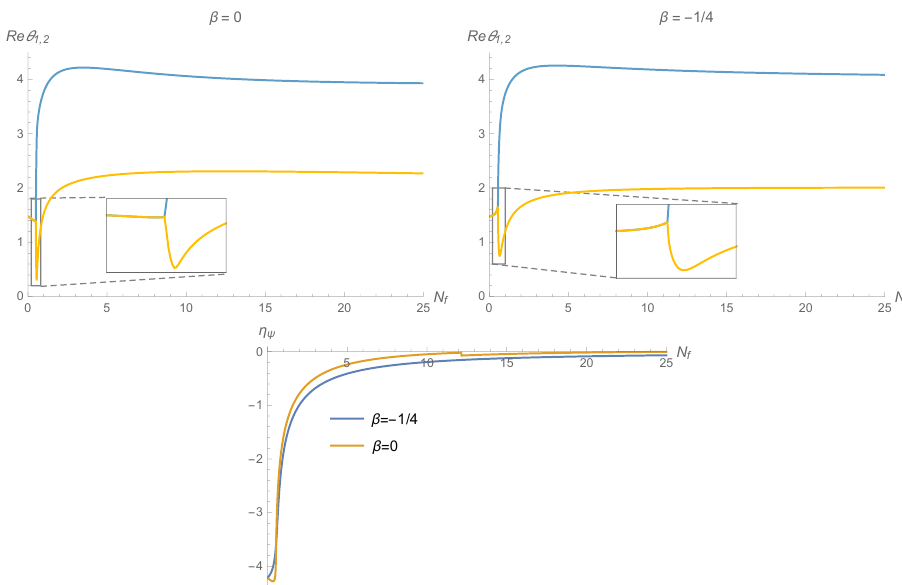
Figure 3. Illustration of the critical exponents (top line) and fermion anomalous dimension (bottom line) for β = 0 and β = − 1/4, respectively. The bifurcation point appearing for low values of N f signals the transition from complex to real critical exponents. The sign change in g ∗ and λ ∗ that occur when β = 0 induces a tiny discontinuity where the fermion anomalous dimension jumps by ∆ η ψ = 0.03 without changing its